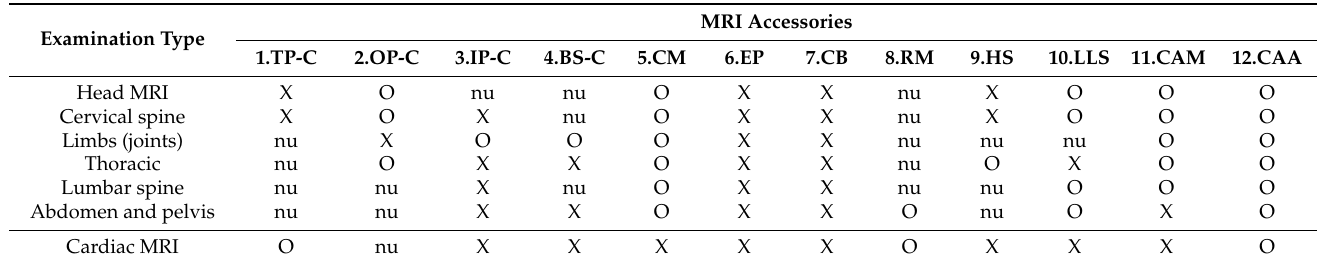
Table 2. Typical MRI accessories used for the most typical adult MRI diagnostic